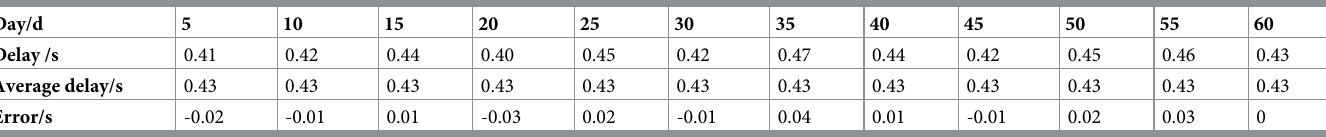
Table 5. Positional delay change on different days for a base station separation of 70 m.